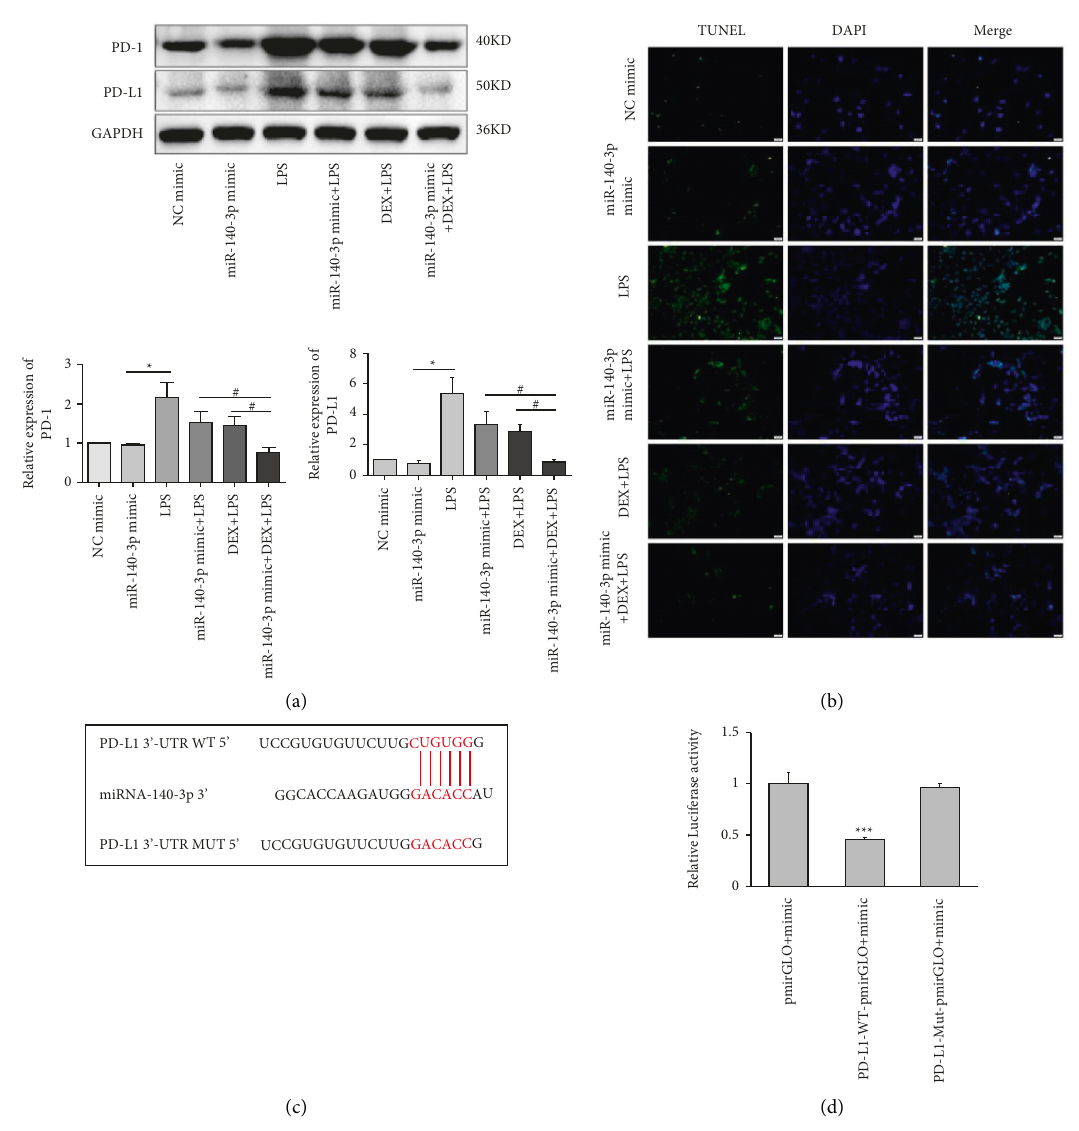
Figure 2: Effects of miR-140-3p overexpression on PD-1/PD-L1 expression and cell viability of RLE-6TN cells. (a) The relative expression of PD-1/PD-L1 in RLE-6TN cells transfected with miR-140-3p mimic. (b) The cell apoptosis of RLE-6TN cells transfected with miR-140-3p mimic detected by TUNEL. (c) Predicted complementary binding site of miR-140-3p in PD-L1 3 ′ -UTR. (d) The relative luciferase activities were inhibited and transfected with the reporter vector WT PD-L1, not with the reporter vector Mut PD-L1. Data are presented as means ± SD ( n � 3; compared to control ∗ p < 0 . 05, compared to LPS-induced # p < 0 . 05, compared to control ∗∗∗ p < 0 .